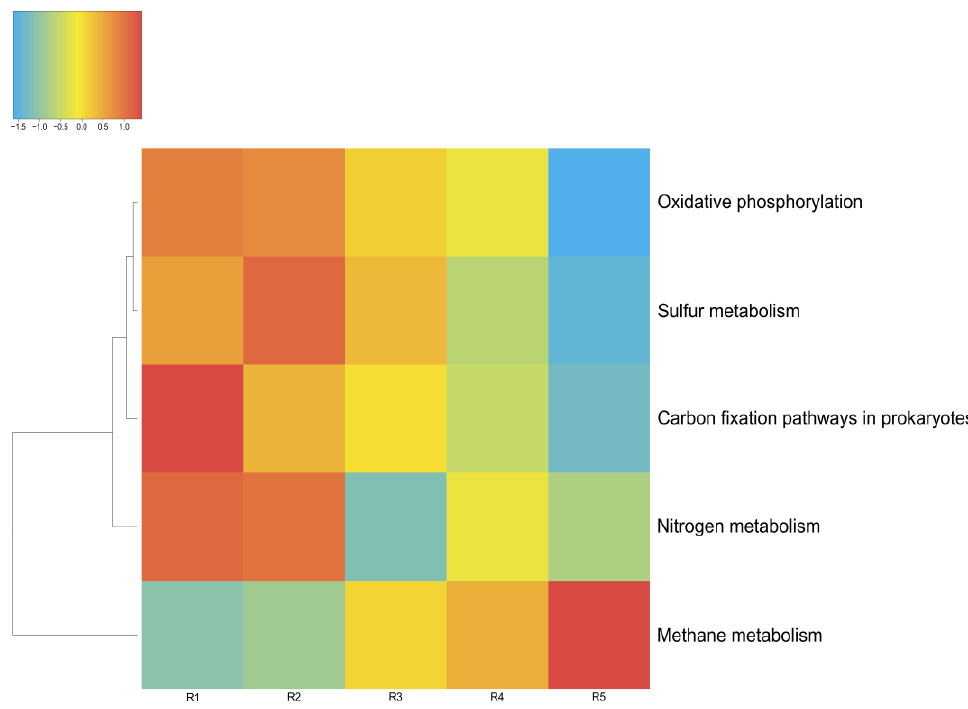
Figure 8. Energy metabolism in the microbial communities of the lake. The color range: − 1.5 is the lowest relative abundance of genes involved in a metabolic process, and 1.0 is the highest relative abundance. Oxygenic and anoxygenic processes of photosynthesis were found in the microbial communities of the lake. Anoxygenic photosynthesis proceeds without oxygen emission; in this case, hydrogen and sulfides are most often electron donors. The fixation of carbon dioxide is carried out by microorganisms of all five of the analyzed layers.